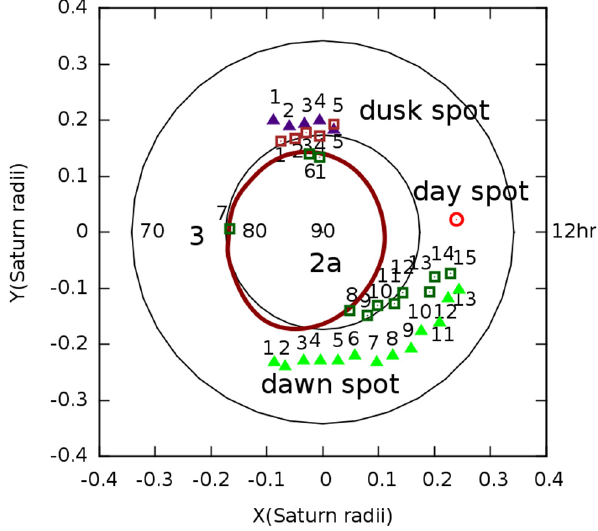
Fig. 8. Northern polar region corresponding to image A, show- ing the auroral boundary points plotted in Fig. 6 mapped along field lines into the northern ionosphere. The brown oval shows the boundary between open and closed field lines for the multipole field and spheroidal ionosphere model.